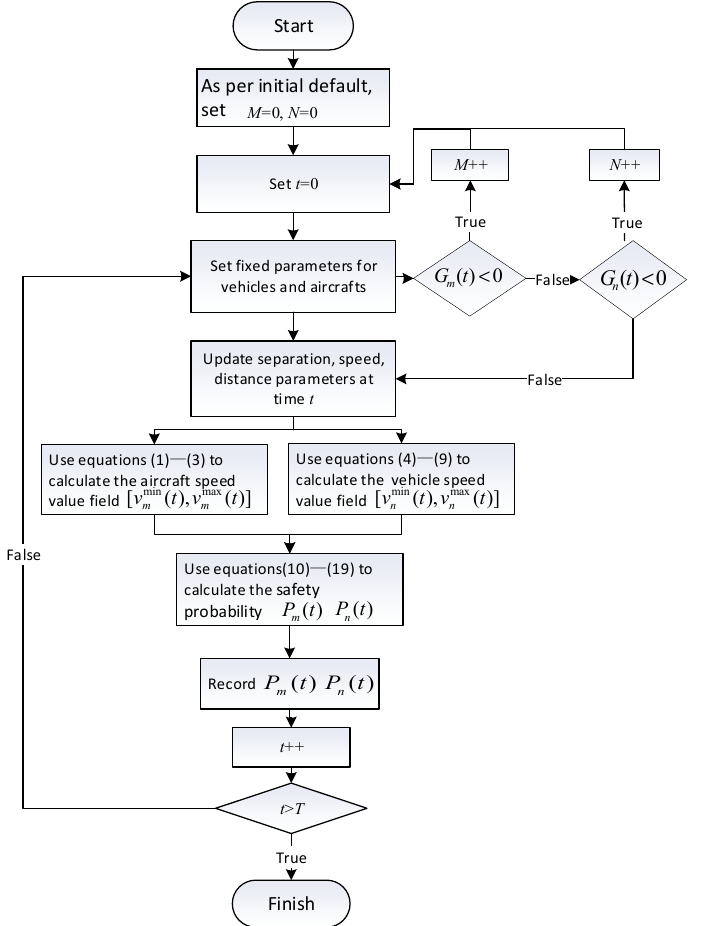
Figure 3. Structure diagram of vehicle and aircraft convergence motion simulation.